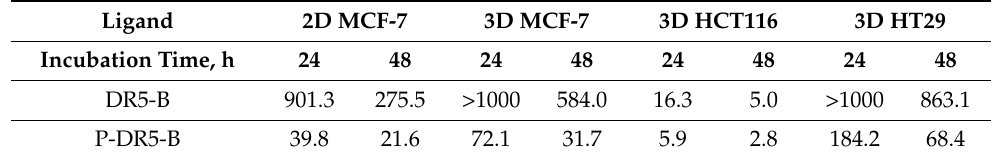
Table 2. IC50 values (ng/mL) of free DR5-B and the P-DR5-B nanoparticles in 2D and 3D in vitro models.